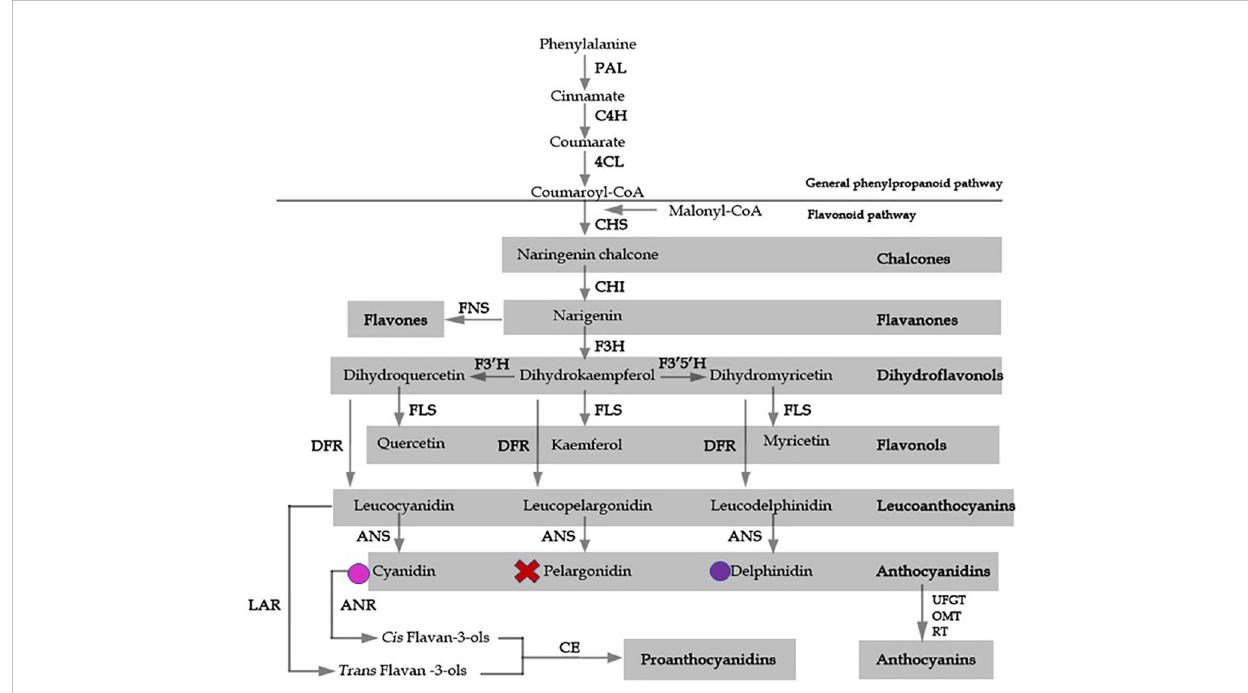
FIGURE 1 A model for fl avonoid biosynthesis in Epimedium fl owers based on classic investigation. Pathway enzymes are listed as an abbreviation beside arrows, and include 4CL, 4-coumarate: coenzyme A ligase; ANS, anthocyanidin synthase; C4H, cinnamate-4-hydroxylase; CHS, chalcone synthase, CHI, chalcone isomerase; DFR, dihydro fl avonol 4-reductase; F3H, fl avavone 3-hydroxylase; F3 ’ H, fl avonoid 3 ’ -hydroxylase; F3 ’ 5 ’ H, fl avonoid 3 ’ 5 ’ hydroxylase; FLS, fl avonol synthase; FNS, fl avone synthase; LAR, leucoanthocyanidin reductase; UFGT, UDP fl avonoid gulcosyl transferase; OMT, O- methyltransferase; PAL, phenylalanine ammonia lyase; RT, rhamnosyl transferase. The products of each enzymatic reaction are listed below the arrows. Colored circles indicate the presence of delphinidin and cyanidin anthocyanidins, X represents absence of